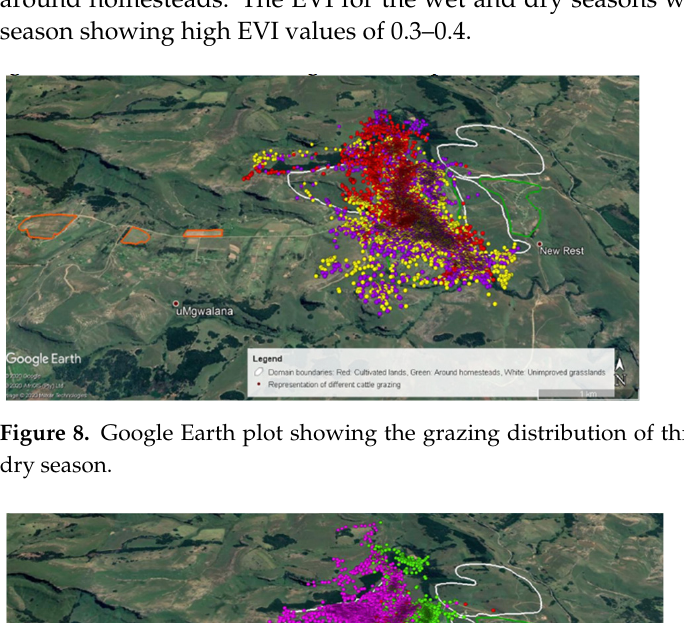
Figure 9. Google Earth plot showing the distribution of three different sheep grazing during the dry season.